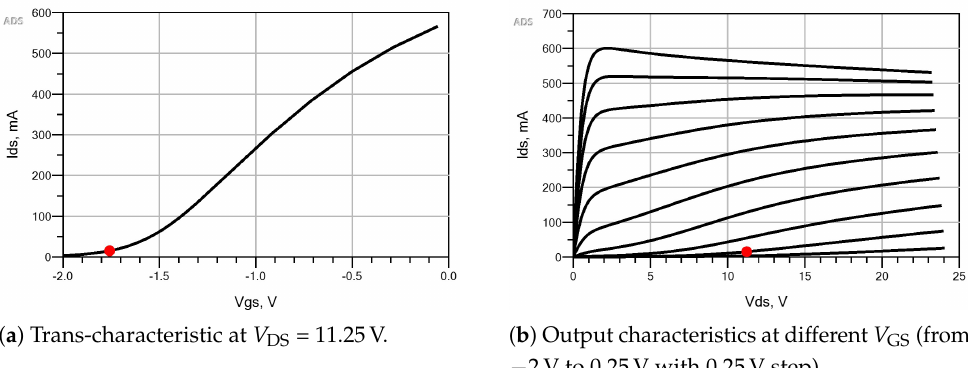
Figure 4. DC characteristics of the 8 × 75 µ m device (black) at T BS = 80 ◦ C and selected bias point (red dot).